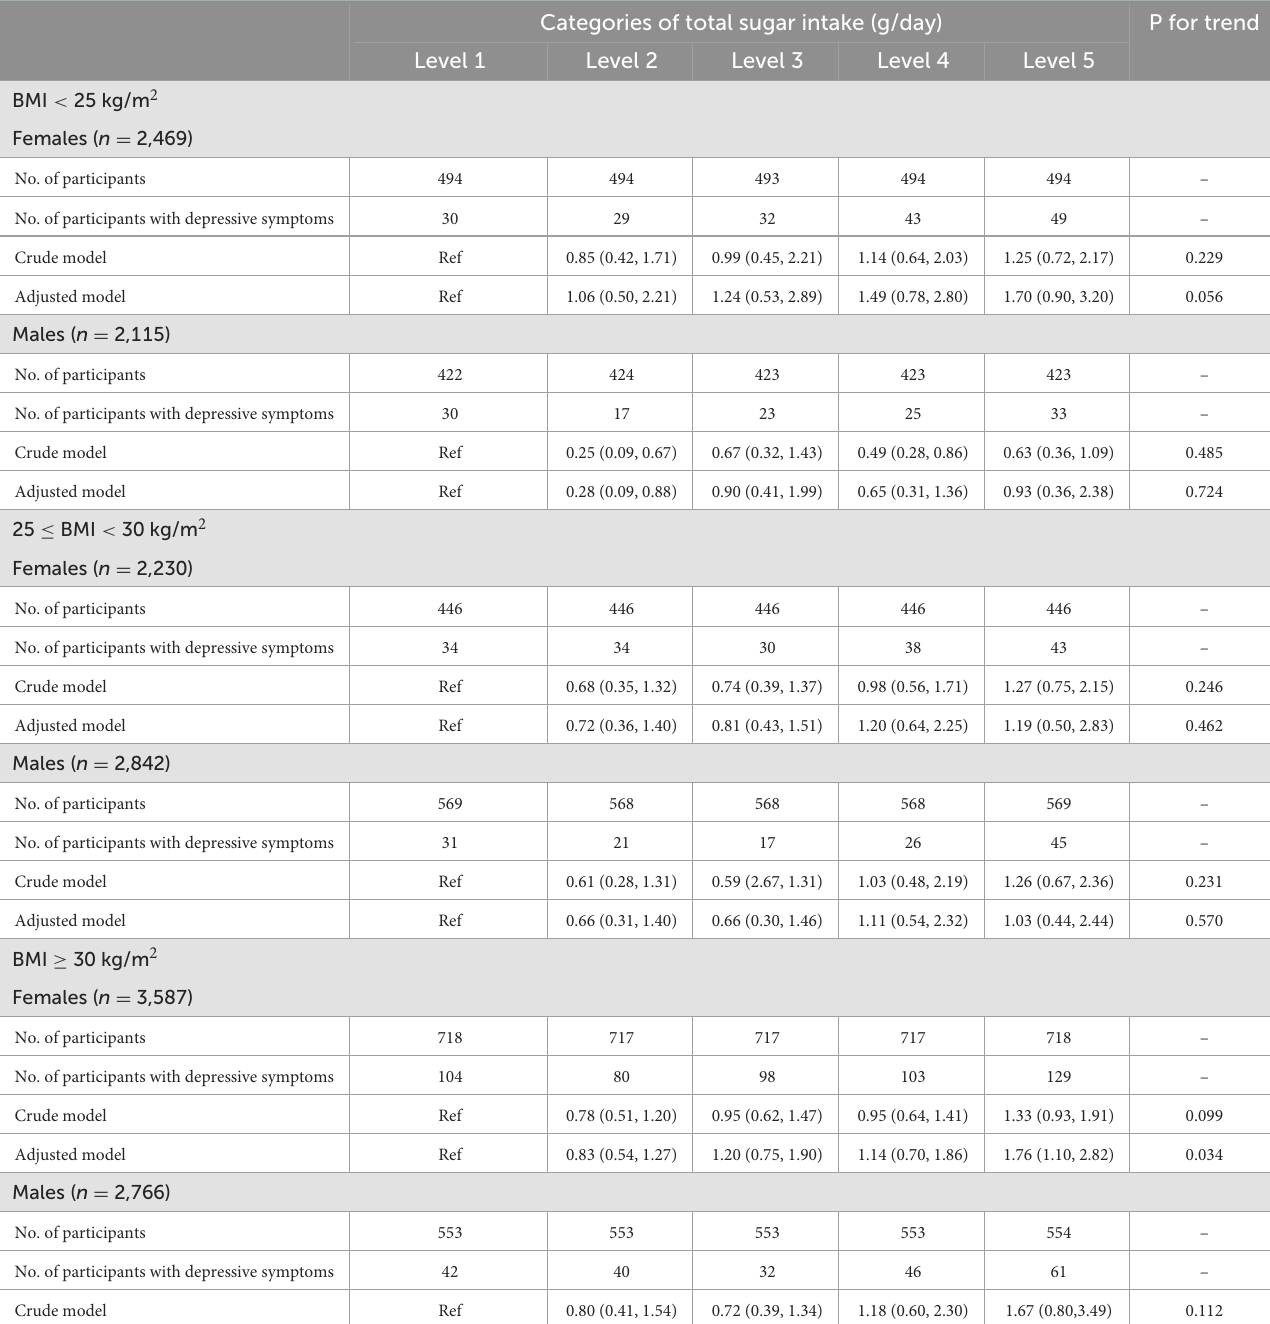
TABLE 4 Associations between total sugar intake and depressive symptoms by gender in normal weight, overweight and obese